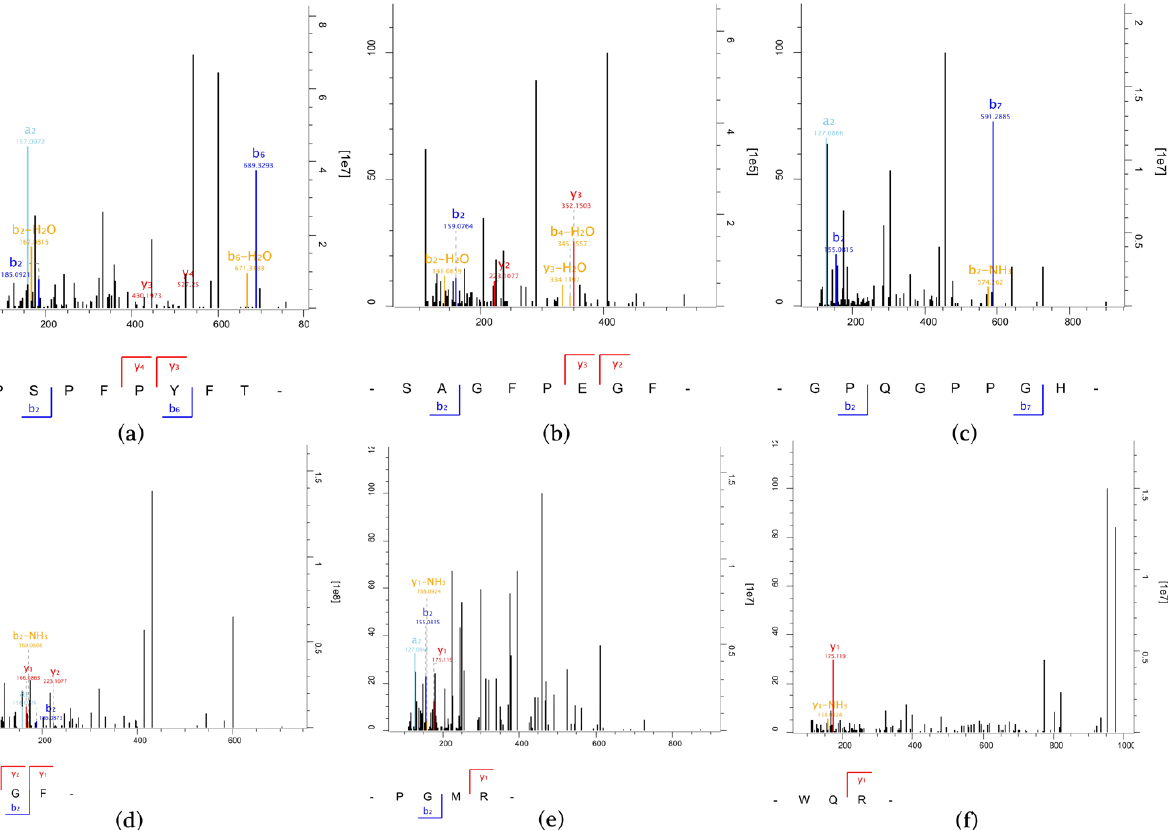
Table 1. Peptide sequences and information scoring of immunomodulatory peptides from L. van- namei heads.